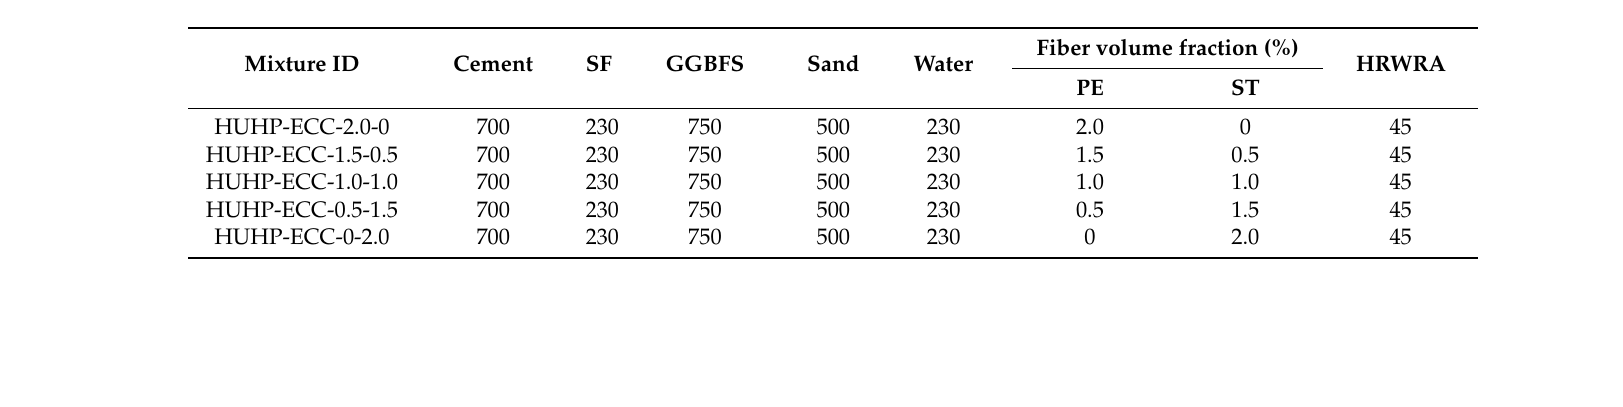
Table 3. Mixture proportion (kg/m 3